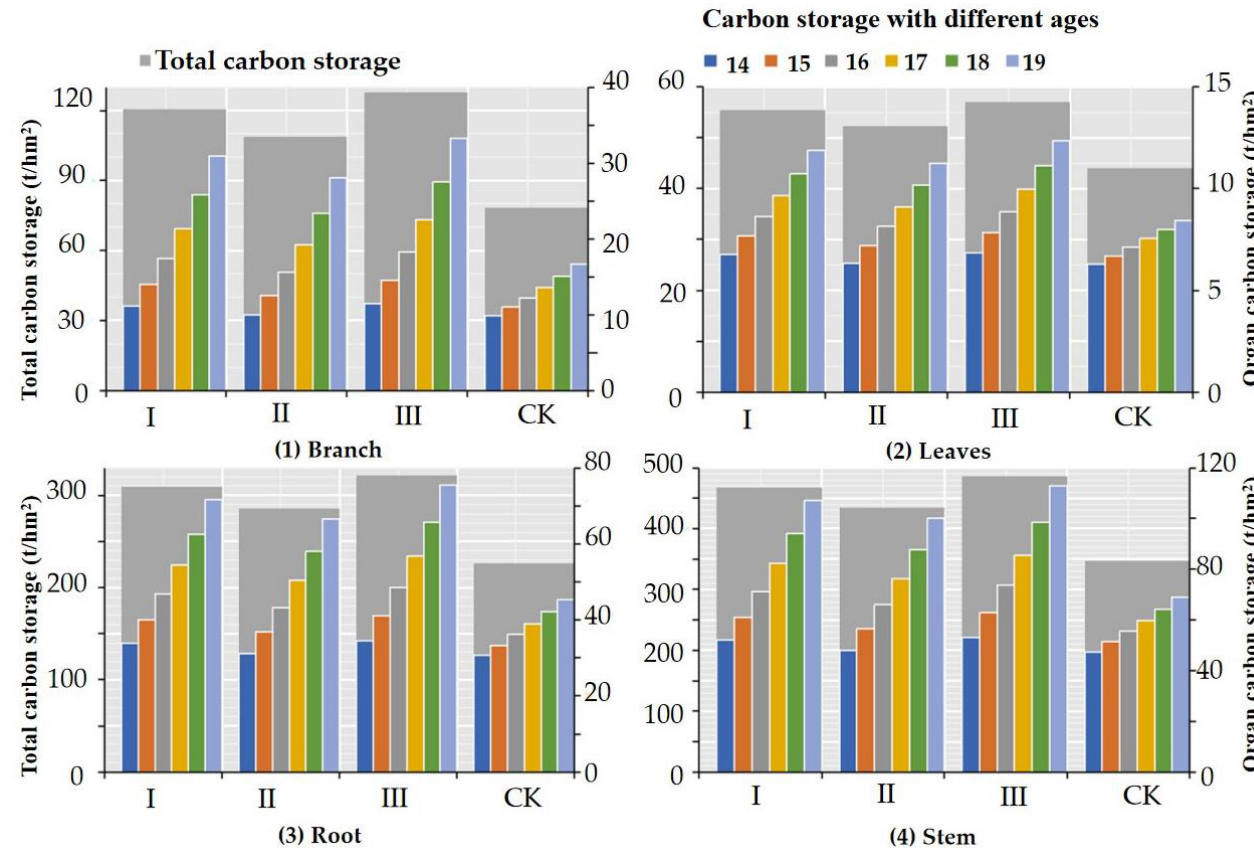
Figure 5. Carbon distribution in the different organs of C. lanceolata plantation as a function of forest age under different thinning intensities.